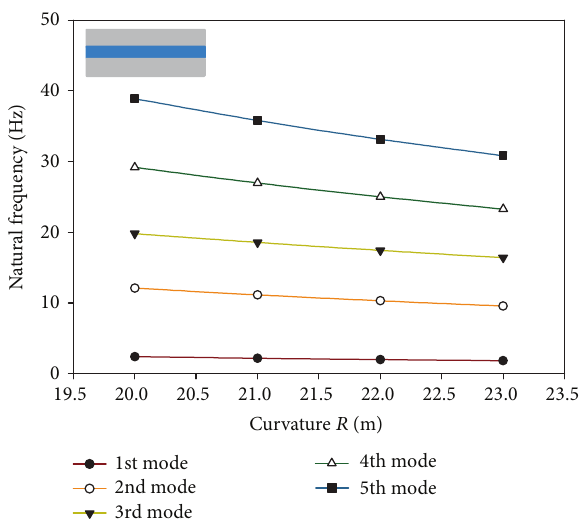
Figure 3: Three cases discussed in this study.